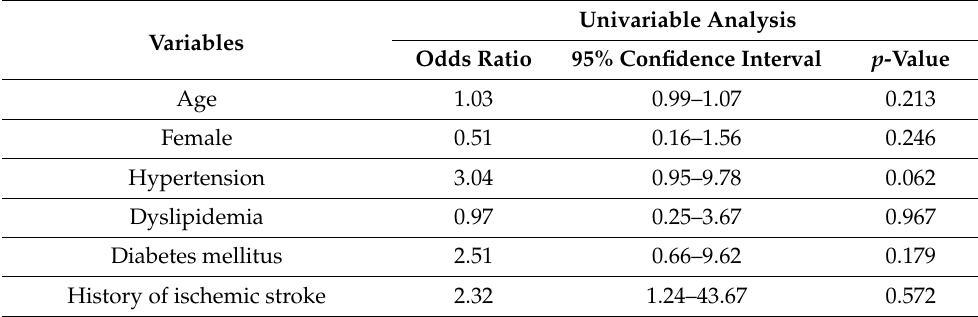
Table 4. Univariable analysis of the demographic and clinical parameters associated with positivity of anti-PF4 antibodies after receiving the first dose of the ChAdOx1 nCoV-19 vaccine.